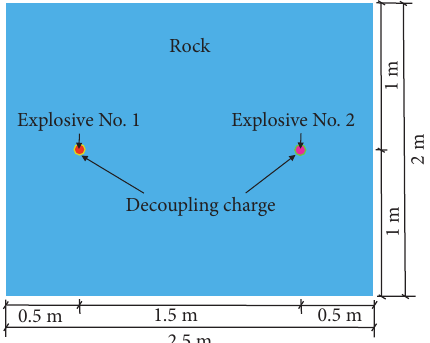
Figure 8: Analysis models with different delay